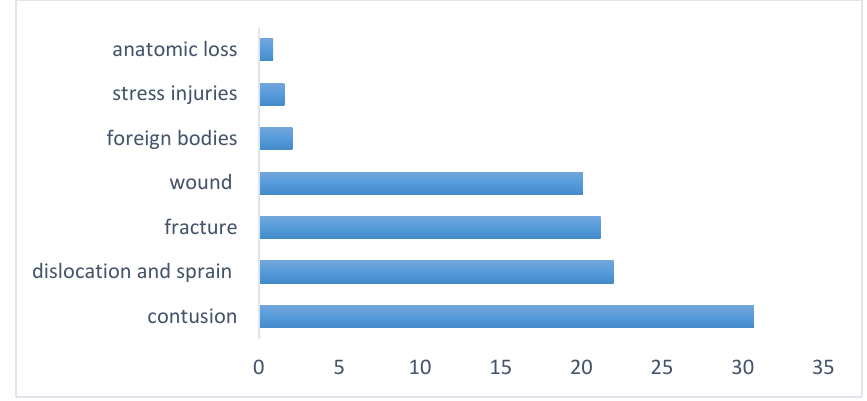
Figure 2. More frequent injuries in agriculture, percentage values [4].